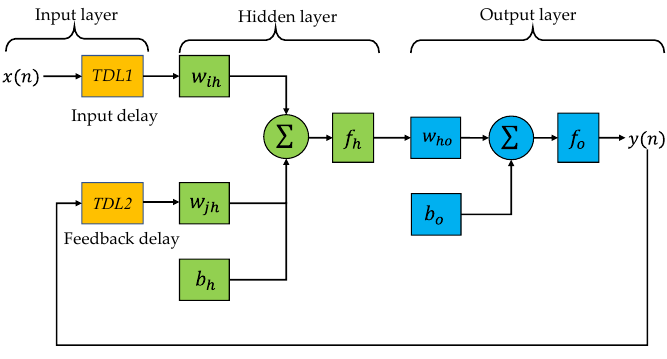
Figure 8. Structure of NARXNN [43].